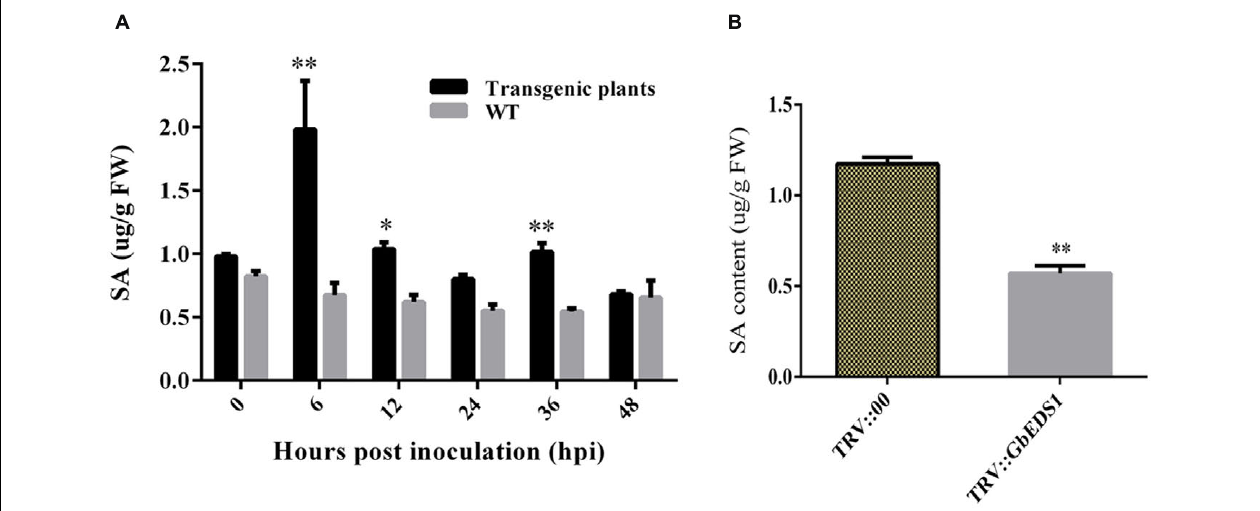
FIGURE 7 | Detection of SA content in Arabidopsis and cotton. (A) Measurement of SA accumulation in transgenic Arabidopsis in response to V. dahliae infection. (B) Measurement of SA accumulation in silenced cotton. Error bars of SA levels represent the SD of three biological replicates; asterisks indicate statistically significant differences, as determined by the Student’s t -test ( ∗ P < 0.05; ∗∗ P <